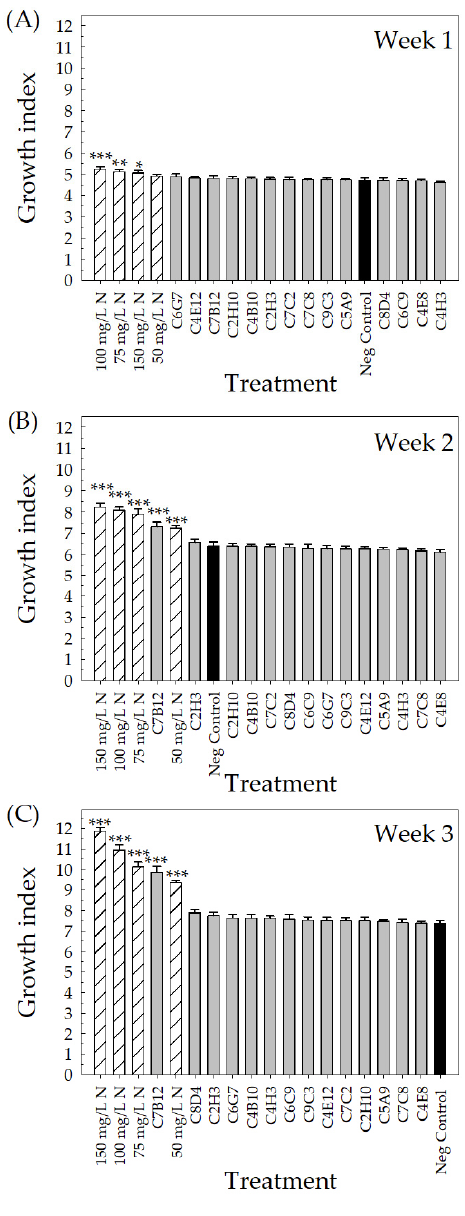
Figure 4. Growth index calculated from the plant height and two perpendicular widths of Petu- nia × hybrida ‘Picobella Blue’ in the greenhouse validation trial treated with 14 bacterial strains selected from the high-throughput greenhouse trials ( n = 12). Growth index measurements are shown for one ( A ), two ( B ), and three ( C ) weeks after transplant. All plants treated with bacteria were fertilized with 25 mg L − 1 N (gray bars). The black bar represents the negative control (no bacterial treatment) fertilized with 25 mg L − 1 N, and the white bars with slanted lines represent the four positive controls (no bacterial treatment) fertilized with either 50, 75, 100, or 150 mg L − 1 N. The treatments were compared to the negative control using Dunnett’s comparison. Significance is represented by *, **, and *** at p ≤ 0.05, p ≤ 0.01, and p ≤ 0.001, respectively. Bars represent the mean, and error bars denote standard